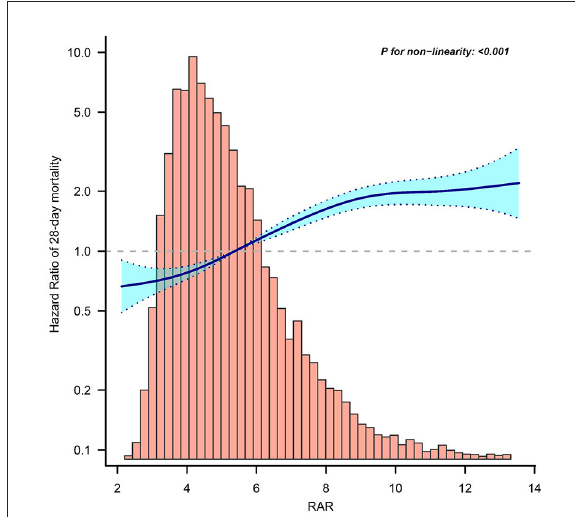
FIGURE2 Curve fitting of RAR and 28-day mortality in patients with sepsis. RAR, Red blood cell distribution width to albumin ratio.